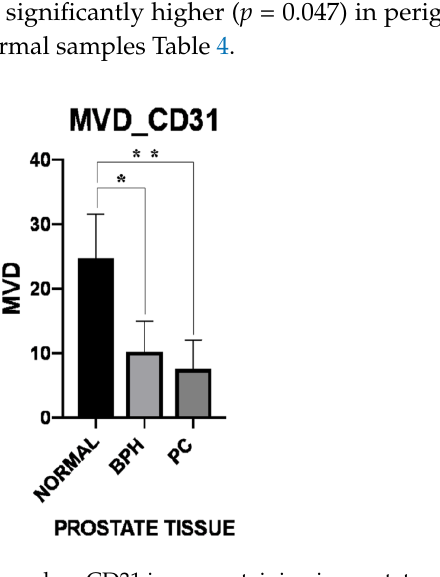
Table 3. Mast cell density (MCD) in periglandular/peritumoral areas versus intraglandular/intratumoral areas based on c-Kit immunoexpression. p -Value is significant in benign prostate hyperplasia (BPH) and prostate carcinoma (PC) groups.